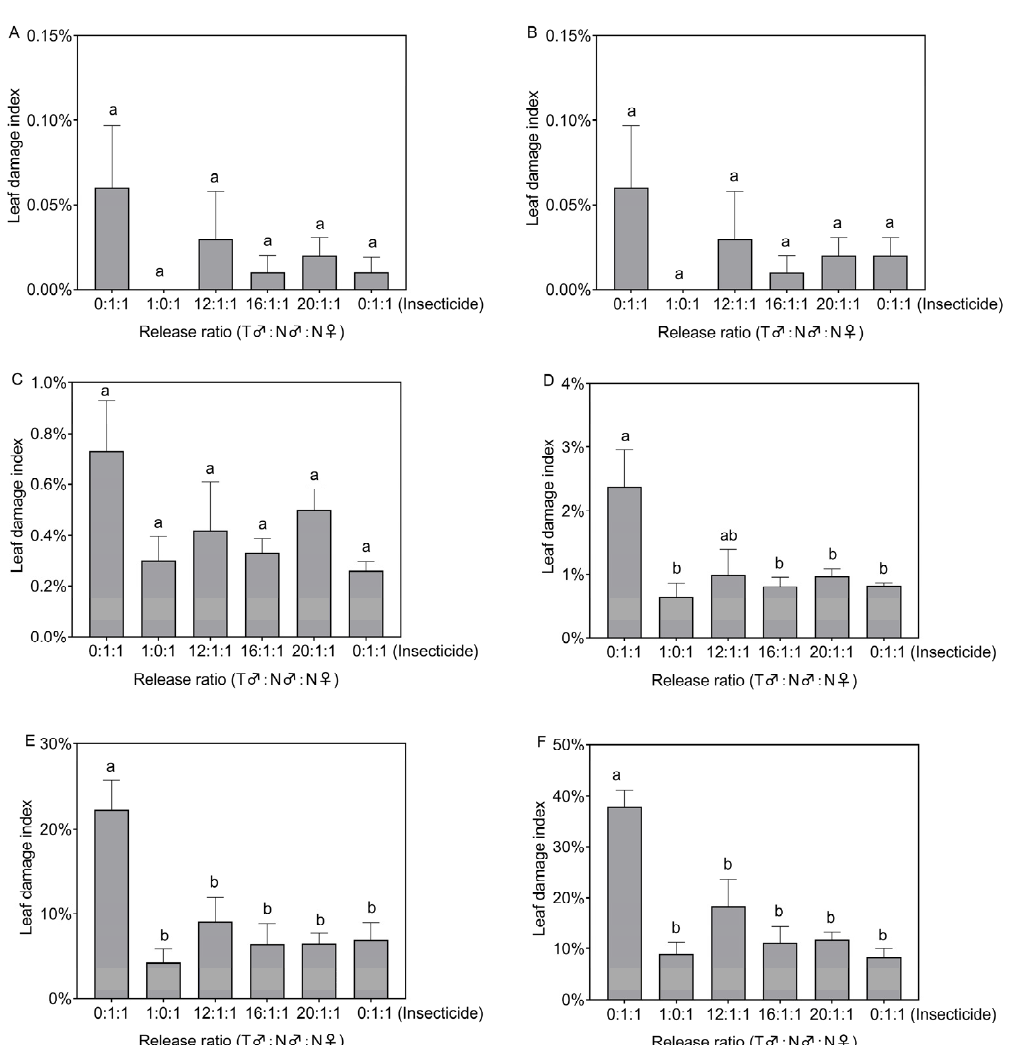
Figure 3. Leaf damage index in the treated plots on the 3rd ( A ), 5th ( B ), 7th ( C ), 9th ( D ), 14th ( E ), and 21st ( F ) days after Spodoptera frugiperda release. Data in the figure are the mean ± standard error; different lowercase letters indicate significant differences (one-way ANOVA, Tukey’s HSD; p < 0.05); T = treated with irradiation; N = not irradiated; insecticide was sprayed on the third day after insect release.